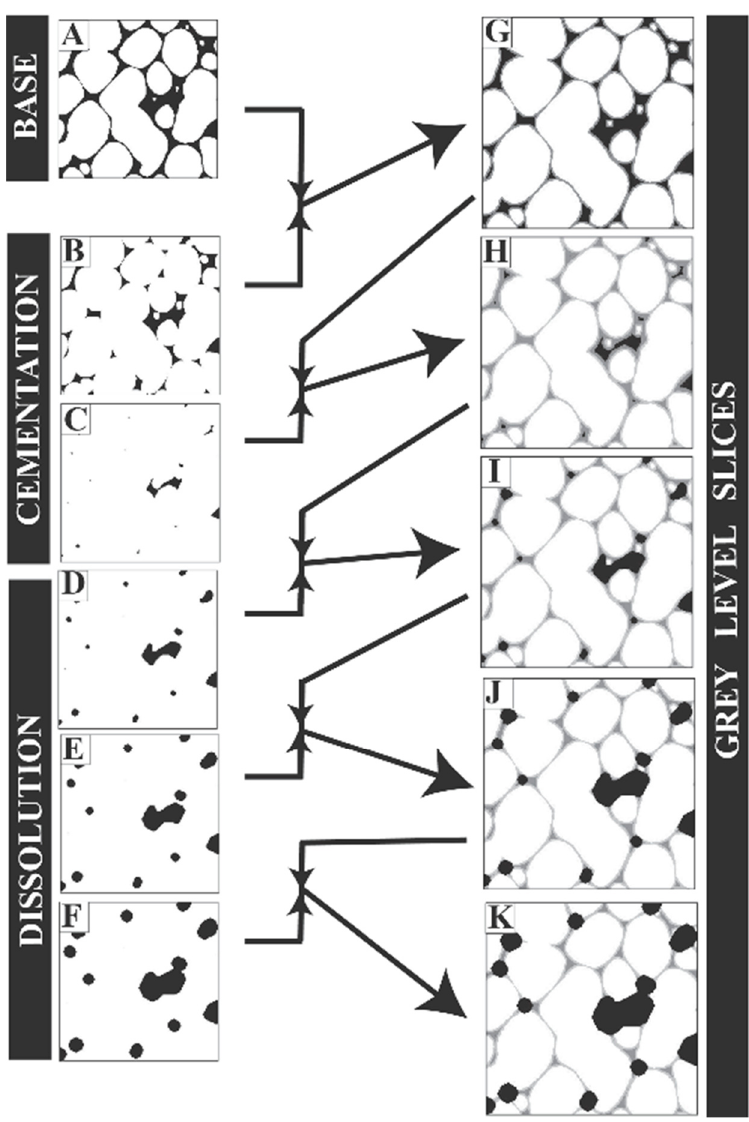
Figure 2. Representative workflow used for cementation and dissolution phases of modelling. ( A ) Horizontal binary slice (2D) through cartoon based 3D model of the base oolite (solid grains and pores only, no cement, etc.). ( B ) and ( C ) same slice as in ( A ), but after the respective addition of phase 1 and phase 2 cement. ( D – F ) As in previous slices, but with the sequential dissolution of pore walls. ( G – K ) Grayscale slices (based on binary slices in ( A – F )), taken from 3D grayscale models; resulting from sequential averaging of consecutive slices / models (i.e., A + B = G, C + G = H, D + H = I, ... ). 3D grayscale models developed to visualise the development of cement and pores. Note that fractures and fracture / pore dissolution was also developed using this method but not illustrated. All slices were 400 voxels × 400 voxels.